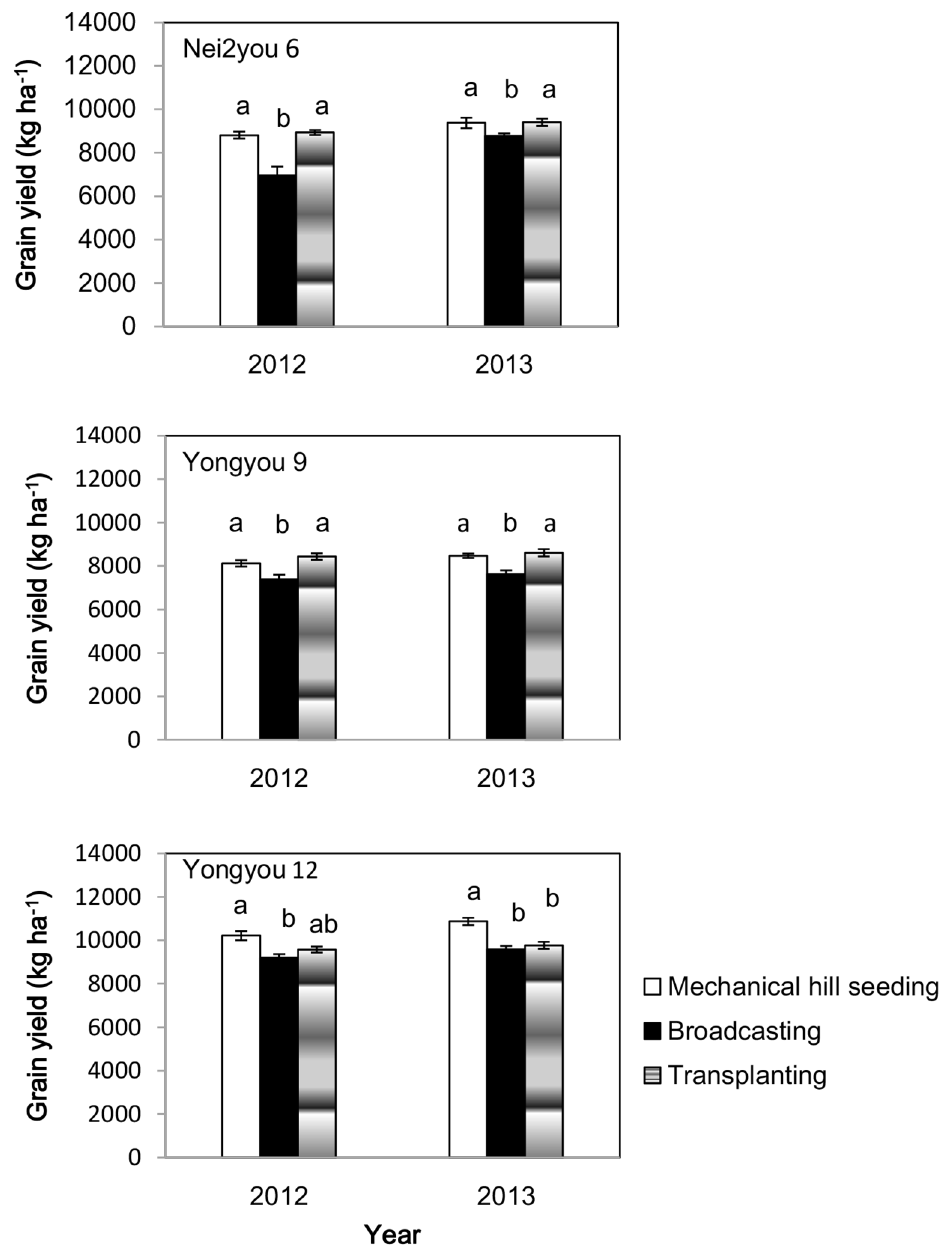
Figure 6. Grain yield of three high-yielding hybrid rice varieties under three plant establishment methods in Fuyang and Yuhang, Zhejiang Province, in 2012 and 2013. Plant spacing for mechanical hill seeding was 25 cm 6 17 cm; broadcasting and transplanting done according to standard farmer’s practice.